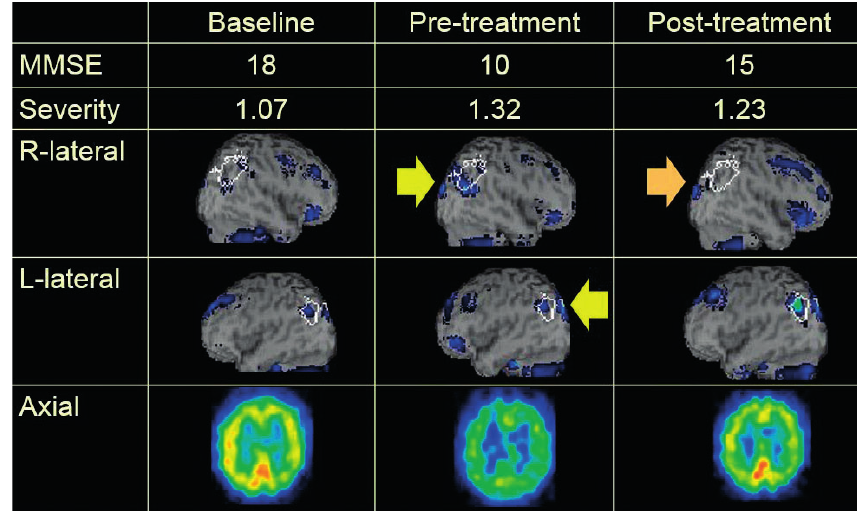
Figure 3. Visuospatial activity with